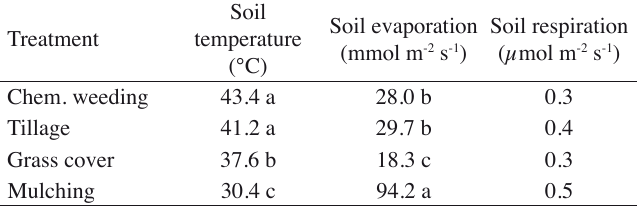
Table 6 - Effect of the different treatments on soil temperature (mea- sured 10 cm below soil level), soil evaporation (measured 5 cm below soil level), and soil respiration (measured 5 cm below soil level). Data are the average of two